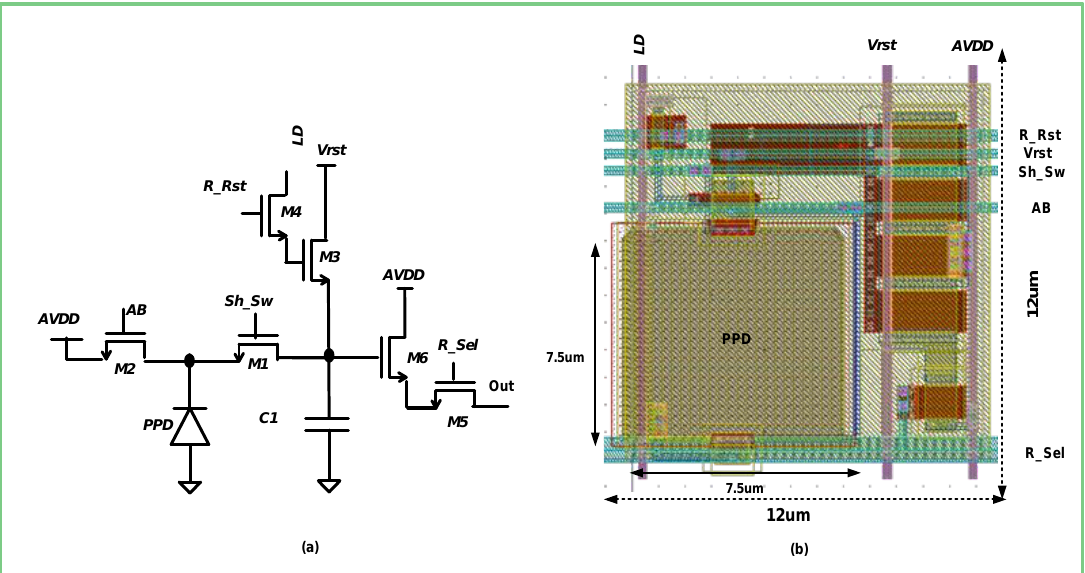
Figure 2. ( a ) Pixel schematic; ( b ) Pixel